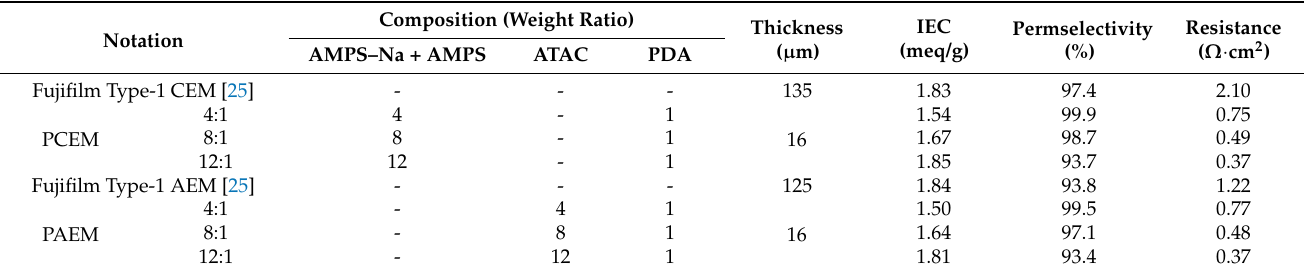
Table 1. Characteristics of pore-filling cation exchange membranes (PCEMs) and pore-filling anion exchange membranes (PAEMs) according to the composition of the electrolyte and crosslinking